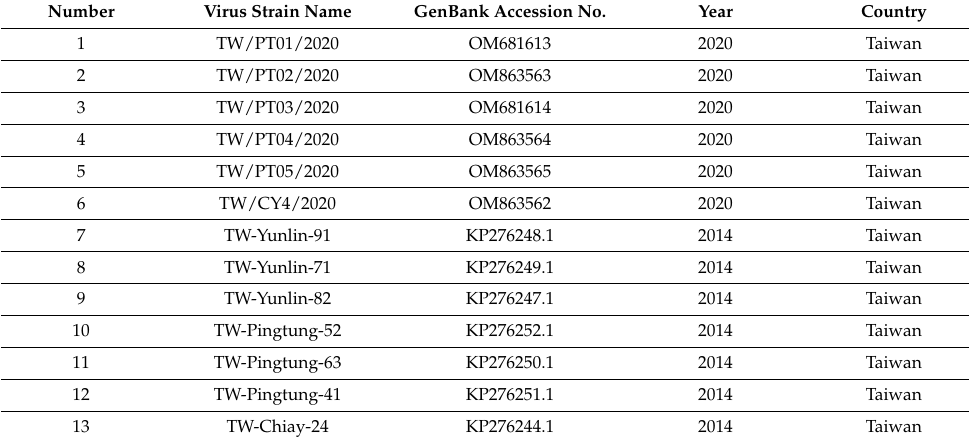
Table A1. List of PEDV reference strains in this